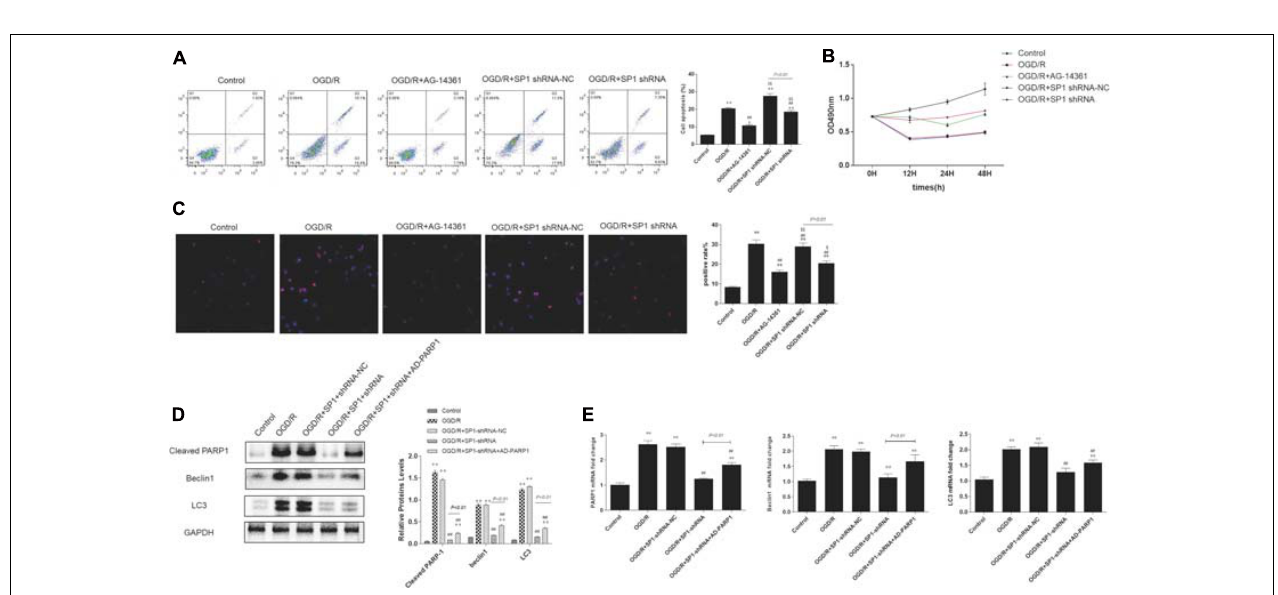
FIGURE 5 | Sp1 suppression prevented cardiomyocytes from OGD/R through PARP1 inhibition. The OGD/R-modeled H9c2 cells were treated with Sp1 shRNA-NC, Sp1 shRNA, PARP1 inhibitor AG-14361 and AD-PARP1 adenovirus. (A) Flow cytometry analysis showed that the percentages of necrotic and apoptotic cells when treating H9c2 cells with Sp1 shRNA, Sp1 shRNA-NC and AG-14361. (B) MTT assay was performed to analyze the cell viability of H9c2 cells when treating H9c2 cells with Sp1 shRNA, Sp1 shRNA-NC and AG-14361. (C) Immunofluorescence showed the positive rate of Sp1 when treating H9c2 cells with Sp1 shRNA, Sp1 shRNA-NC and AG-14361. Magnification: 200 × . (D) Western blot showed the expression of PARP1 and autophagy related proteins when treating H9c2 cells with Sp1 shRNA, Sp1 shRNA-NC and AD-PARP1 adenovirus. (E) Real-time PCR showed the mRNA level of PARP1 and autophagy related proteins when treating H9c2 cells with Sp1 shRNA, Sp1 shRNA-NC and AD-PARP1 adenovirus. Compared with control group, * P < 0.05, ** P < 0.01; compared with OGD/R group, # P < 0.05, ## P < 0.01; compared with OGD/R+AG-14361 group, $ P < 0.05, $$ P < 0.01. N = 4 for each group.